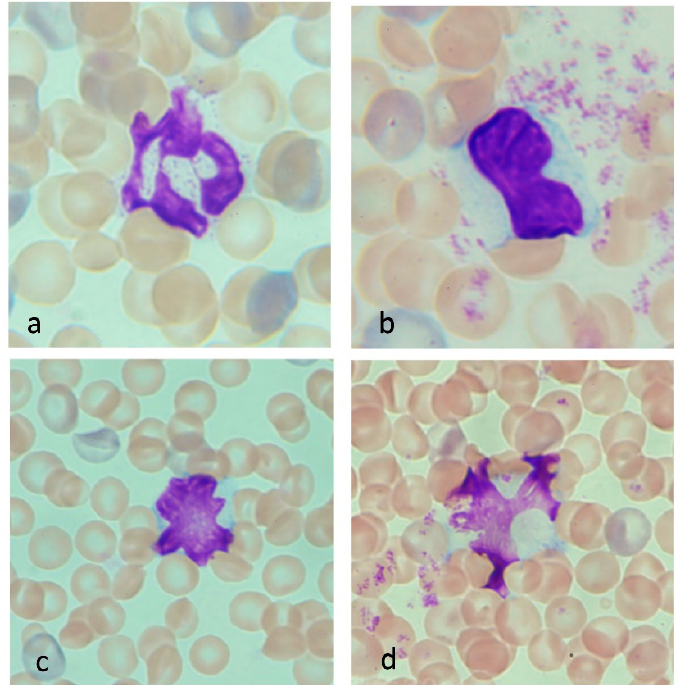
Figure 3. Neutrophils, monocytes, erythrocytes, and lymphocytes in severe heatstroke. A neutrophil from the animal with severe heatstroke showed a multilobed nucleus ( a ). Monocytes with platelet aggregates were frequently seen in the samples from the severe heatstroke rats. The red blood cells were stained heterogeneously ( a – d ). Erythrocytes with blue-red color represent the reticulocyte (polychromatic [polychromatophilic] erythrocyte). The lymphocytes from healthy control rats have a round or oval nucleus and narrow cytoplasm. In contrast, lymphocyte from heatstroke rats has scalloped, angle-edged, or cleaved nuclei with nuclear bodies. The lymphocyte has a relatively large cytoplasm and is namely reactive lymphocyte ( c ). Other than that, lymphocytes sometimes showed a blast-like change represented by a large, light-stained, dispersed chromatin pattern with prominent nucleoli. These changes were thought to be induced by the damage of heat. Lymphocytes sometimes showed ruptured nuclei ( d ) or lysed cytoplasmic body that represents oncosis (necrosis).